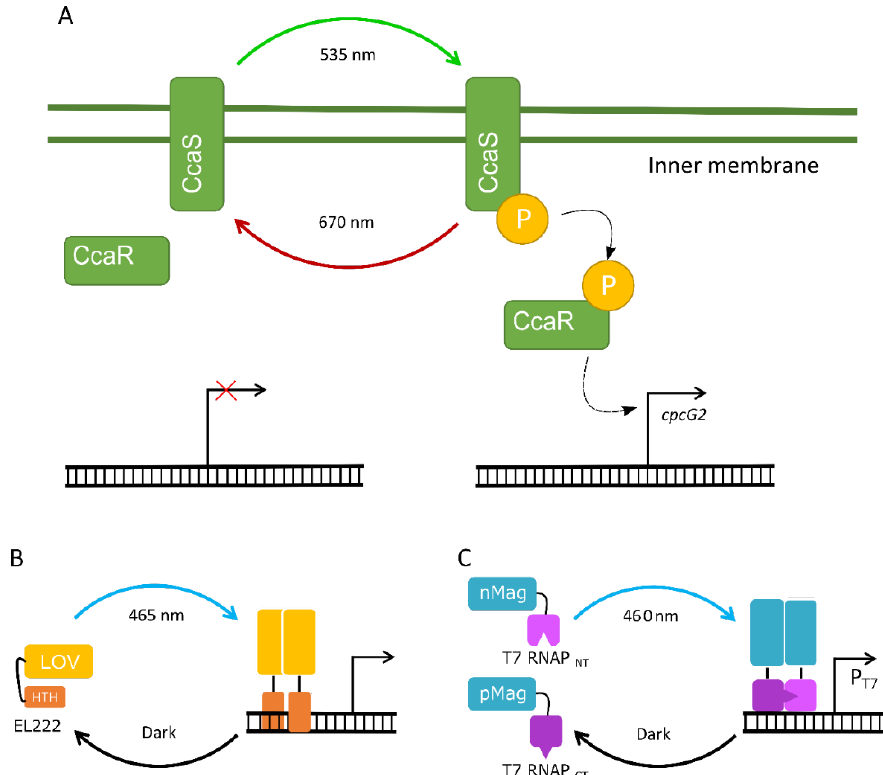
Figure 3. Examples of optogenetic two-component and one-component systems. ( A ) The two-component green light-inducible CcaS/CcaR system native to Synechocystis sp. PCC 6803. In the presence of green light (535 nm), the histidine kinase CcaS is phosphorylated and, in turn, phosphorylates the response activator CcaR, which results in expression of cpcG2 [191,196]. ( B ) The EL222 transcription factor from Erythrobacter litoralis HTCC2594 is a one-component system. Blue light induces a conformational change between the LOV and the Helix-Turn-Helix (HTH) DNA binding domain, allowing dimerisation and DNA binding [187]. ( C ) Split T7 RNA polymerase (RNAP) fused to the Vivid (VVD) photoreceptor from Neurospora crassa is a one-component system. In blue light, the two subunits of VVD (nMag and pMag) interact to assemble the split T7 RNAP (T7 RNAP NT and T7 RNAP CT ) as a functional RNA polymerase